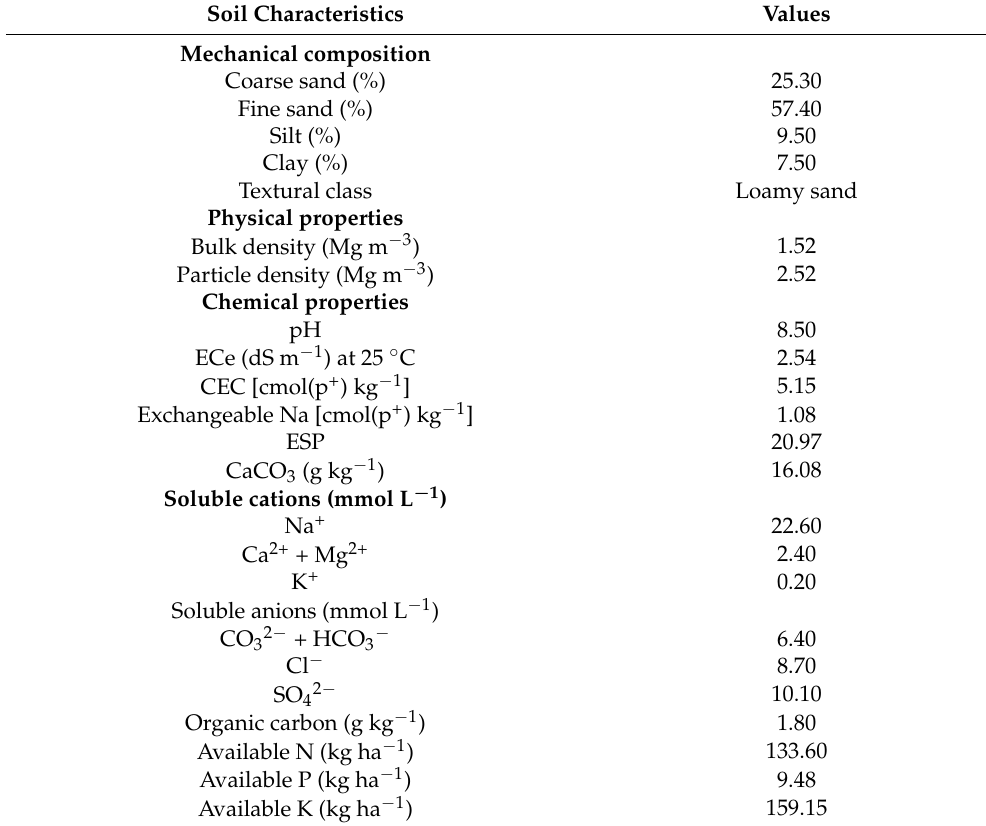
Figure 5. Experimental site and growing period of mustard ( Brassica juncea (L.) Czern.) crop in arid region. Table 5. Basic soil (0–15 cm) physico-chemical characteristics of experiment